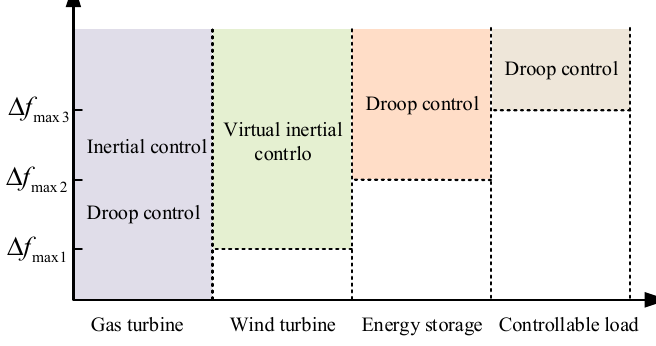
Figure 2. Hierarchical coordinated frequency control architecture.